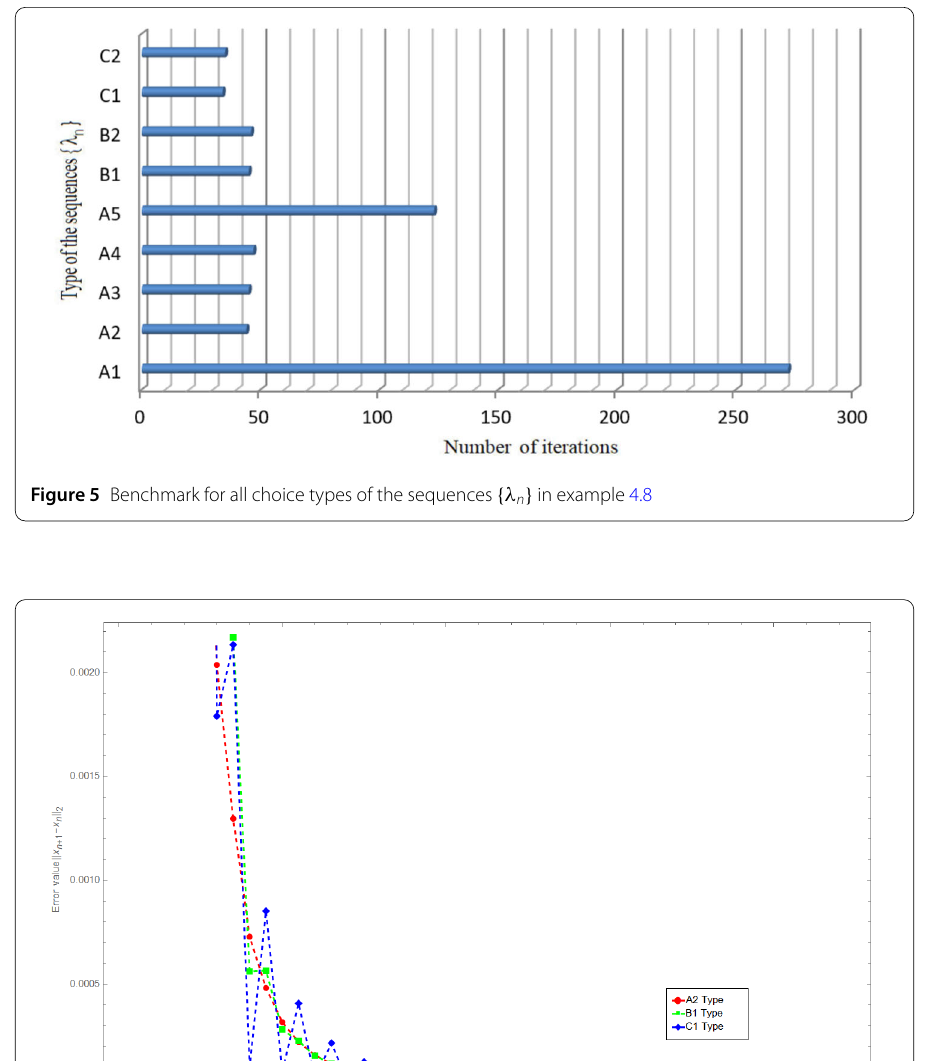
which is a particular case of the convex minimization problem (4.2) when G = 0. It is well